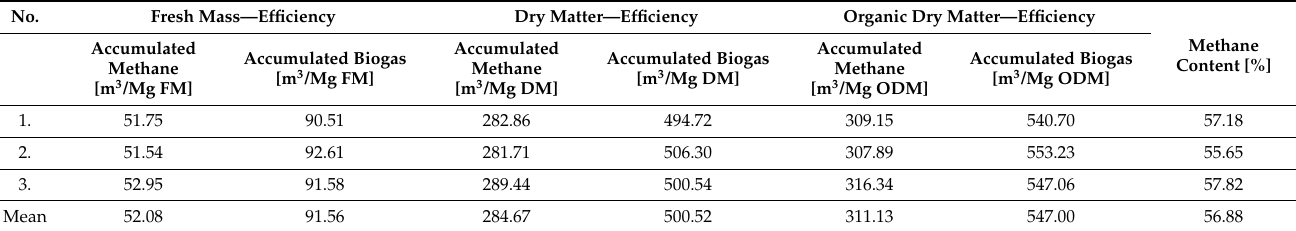
Table 8. Biogas yield from giant miscanthus